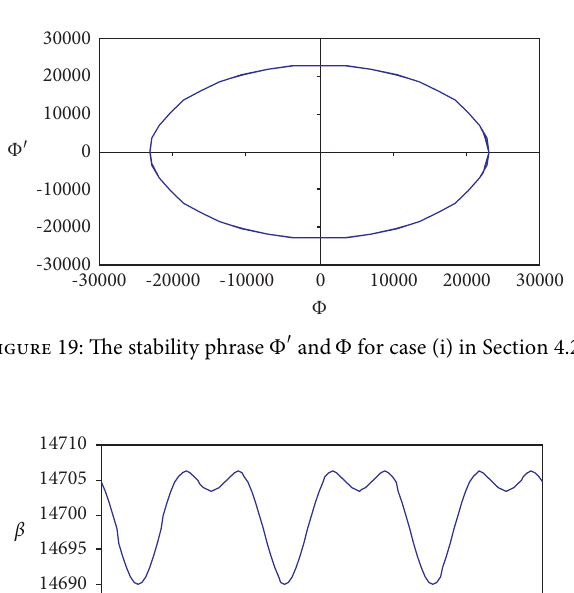
Figure 14: The analytical solution β for case (i) in Section 4.1.